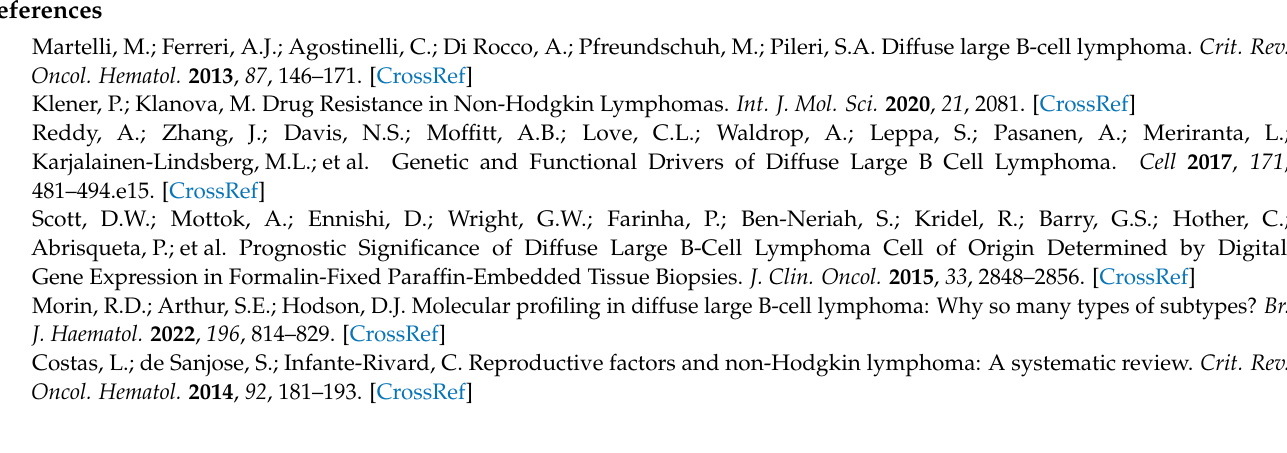
DLBCL cohort; Table S3: Differential gene expression in females vs. males; Table S4: GCB DLBCL subtype, female vs. male hallmark pathway analysis; Table S5: ABC DLBCL subtype, female vs. male hallmark pathway analysis; Table S6: GCB DLBCL subtype, genes differentially in pre- vs. post- menopausal females; Table S7: ABC DLBCL subtype, genes differentially in pre- vs. postmenopausal females; Table S8: ABC DLBCL subtype, genes differentially expressed females vs. males; Table S9: GCB DLBCL subtype, genes differentially expressed females vs. males. Supplementary